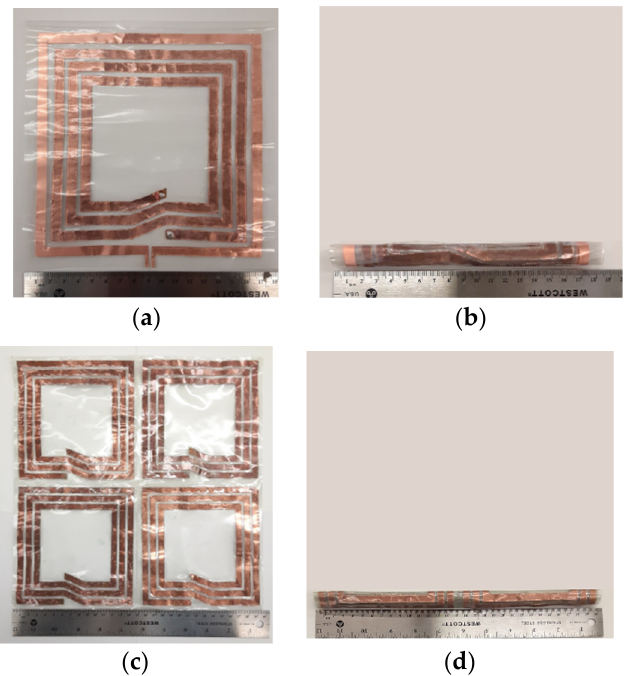
Figure 10. Fabricated rollable MS-based WPT system: ( a ) Tx/Rx (rolled up), ( b ) Tx/Rx (halfway rolled down), ( c ) MS screen (rolled up), ( d ) MS screen (halfway rolled down).